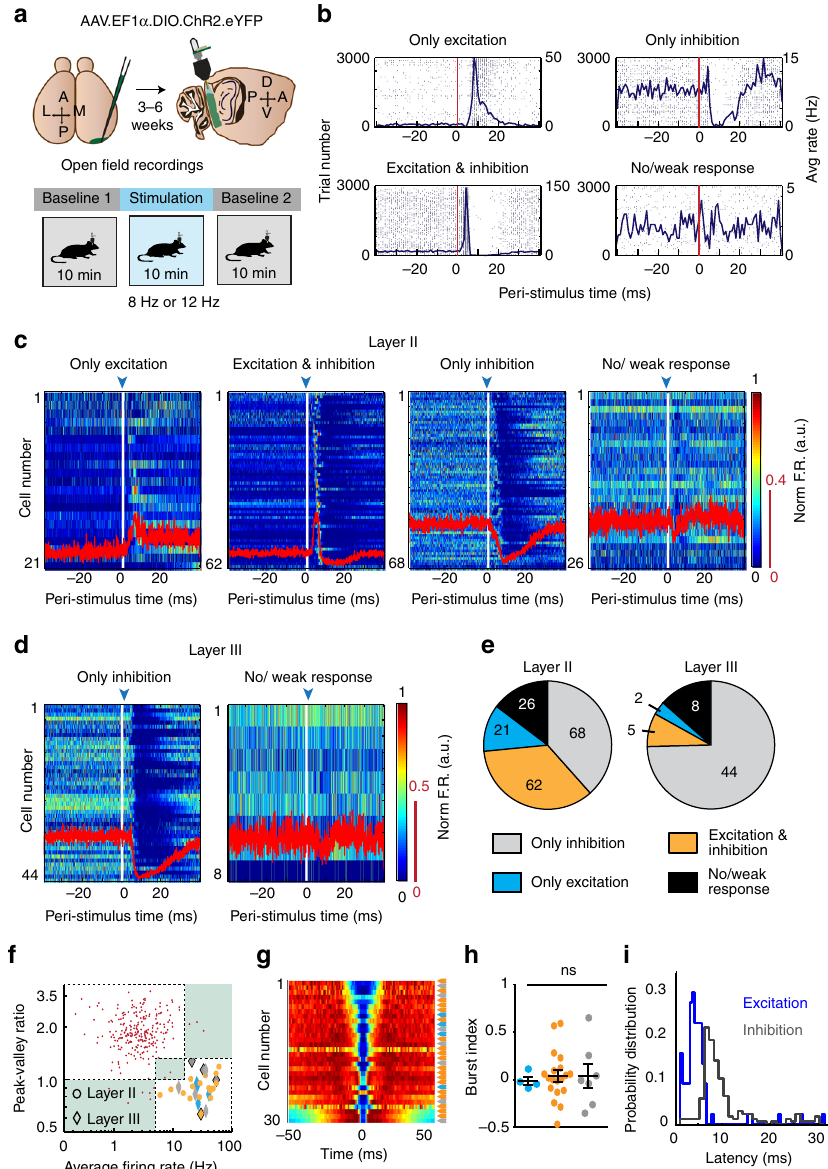
Fig. 2 Functional connectivity of LIIP cells. a Schematic describing the recording strategy and behavioral paradigm. b Cells were divided into four categories, depending on how they responded to the photostimulation. Example raster plots and peri-stimulus time histograms for each of the categories are shown. Vertical red lines indicate light onset. c All recorded mEC LII principal cells divided by response category. Each row is the peri-stimulus fi ring rate of a single cell, normalized to its peak fi ring rate (scale, color bar to the right). The cells are sorted by their response latencies. Excited cells have a sharp peak within 10 ms after the light pulse, whereas inhibited cells reduce their fi ring rate up to ~30 ms after the light onset. Red traces, mean normalized fi ring rate across all cells within the category (scaled to the red bar on the right). Blue arrow, light onset. d Plots as described in c but for cells recorded in LIII. Primarily inhibition was observed in LIII cells, thus the excitatory responses of <15% of cells are not shown. e Quanti fi cation of responses shows that ~85% of LII and LIII cells were perturbed by the stimulation. f Average fi ring rates on a logarithmic scale versus the peak-valley ratio of the spike waveform of all cells distinguished putative principal cells (red dots) from interneurons. Cells outside of or between the two clusters were excluded from further analyses (sections in green). Thirty putative interneurons were recorded, 26 from LII (circles) and 4 from LIII (diamonds). Color code as in e . g Color-coded (maximum, red; minimum, blue) autocorrelograms of all interneurons ordered by their burst index and with the response category of each cell denoted by colored dots on the right (color scheme as in e ). h The burst index (mean ± sem) of putative interneurons is plotted by response category (color scheme as in e ). Response category did not predict burstiness [Kruskal – Wallis test, H (3) = 3.124, p = 0.2097]. i Distribution of the latencies for excited (blue line) and inhibited (gray line) principal cells. Excitation occurred rapidly and was followed by feedback